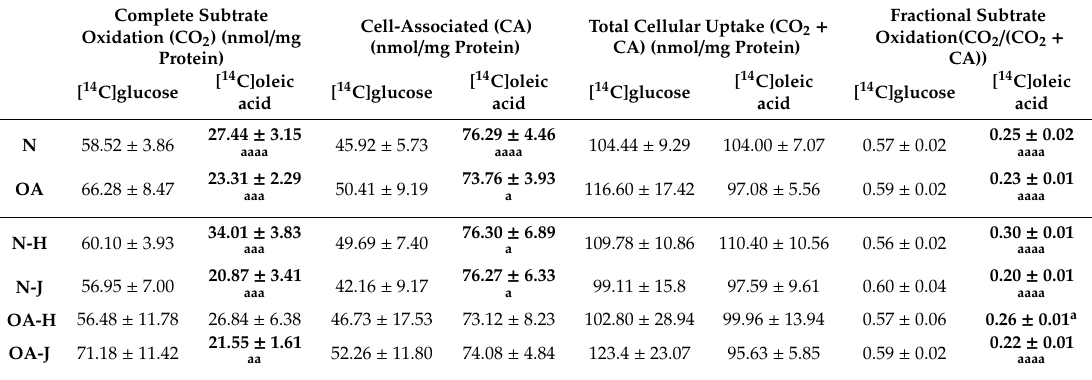
Table 1. Comparison between basal glucose and FA metabolism from healthy (N) and osteoarthritis (OA) cybrids and carrying haplogroups H or